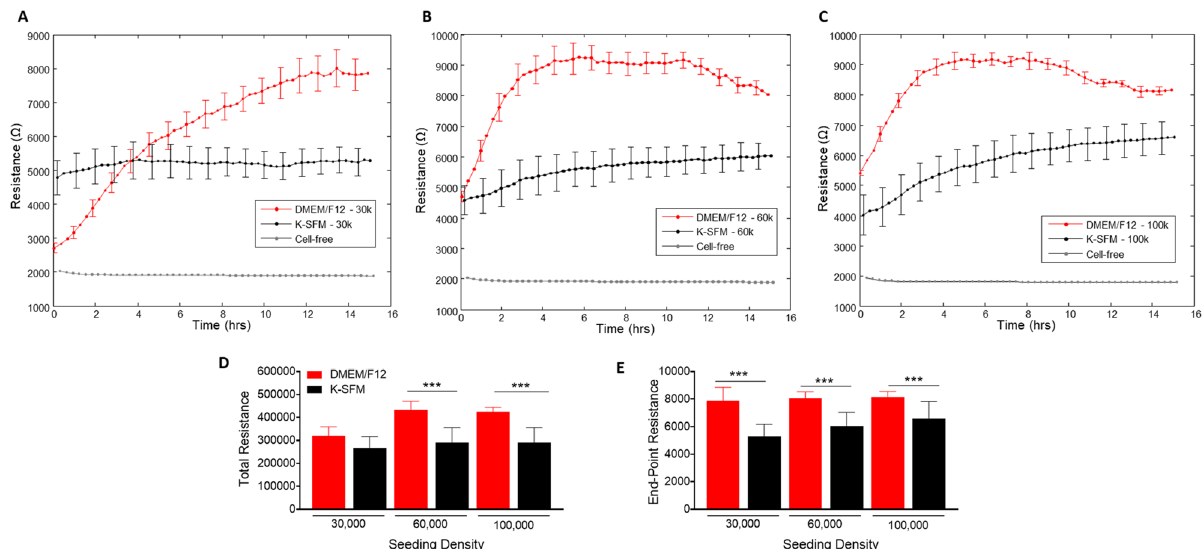
Figure 4. Real-time monitoring of HUCL resistance in DMEM/F12 versus K-SFM media. Resistance of HUCLs versus time, measured at an AC frequency of 4000 Hz for 30,000 ( A ), 60,000 ( B ) and 100,000 ( C ) cell seeding densities is shown. Bar graph representation of total resistance ( D ) and end-point resistance ( E ) comparing DMEM/F12 versus K-SFM. Time = 0 h denotes time of inoculation. Data shown are the mean ± SEM; n = 5/group. *** p ≤